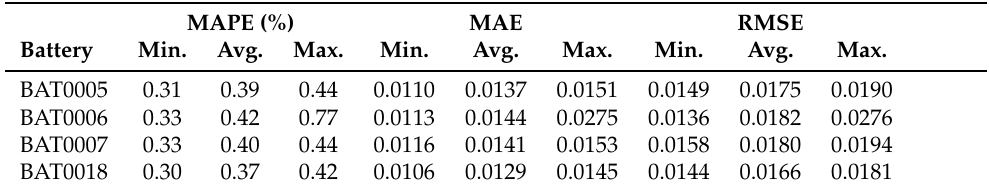
Table 4. Prediction error between batteries. MAPE (%) MAE RMSE Battery Min. Avg. Max. Min. Avg. Max. Min. Avg. Max.